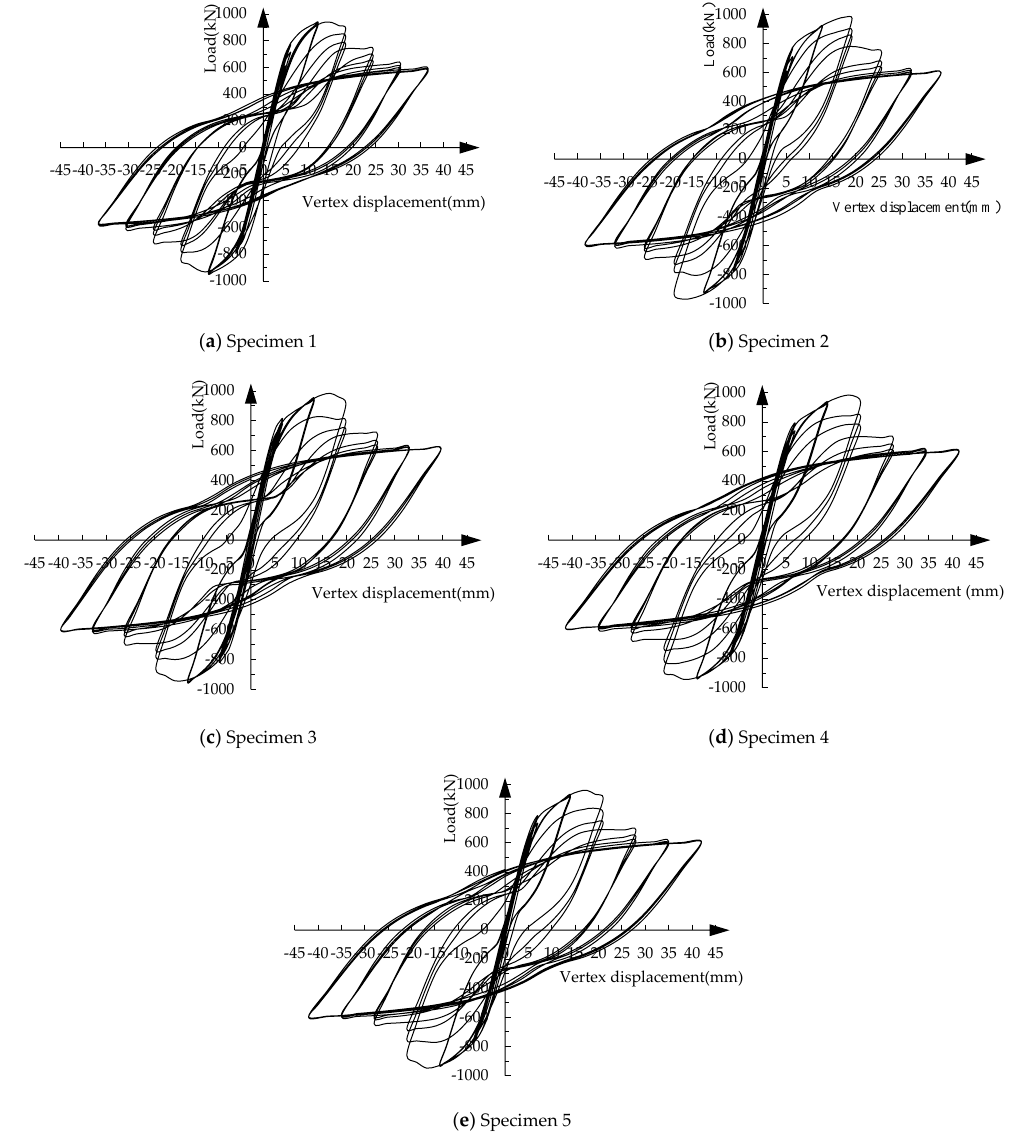
Figure 19. Load ‒displacement hysteresis curves under low cyclic loading. Figure 19. Load–displacement hysteresis curves under low cyclic Under low cyclic loading, the energy dissipation capacity can be measured by the area surrounded by the hysteresis loop. Based on the load‒displacement hysteresis curve obtained by finite element simulation, the approximate integral method is used to calcu- late the single-cycle energy dissipation value when completing a hysteresis loop. After that, the cumulative energy dissipation value is calculated in turn to evaluate the energy dissipation performance. Because the specimen is basically in the elastic stage during the